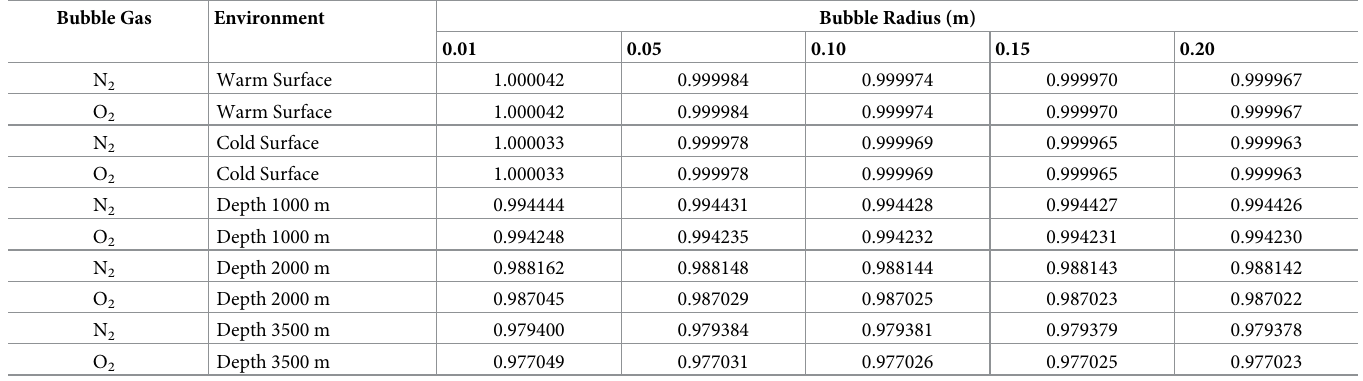
Table 2. Ratio of far-field resonance frequency to undamped frequency for selected bubble radii. Bubble